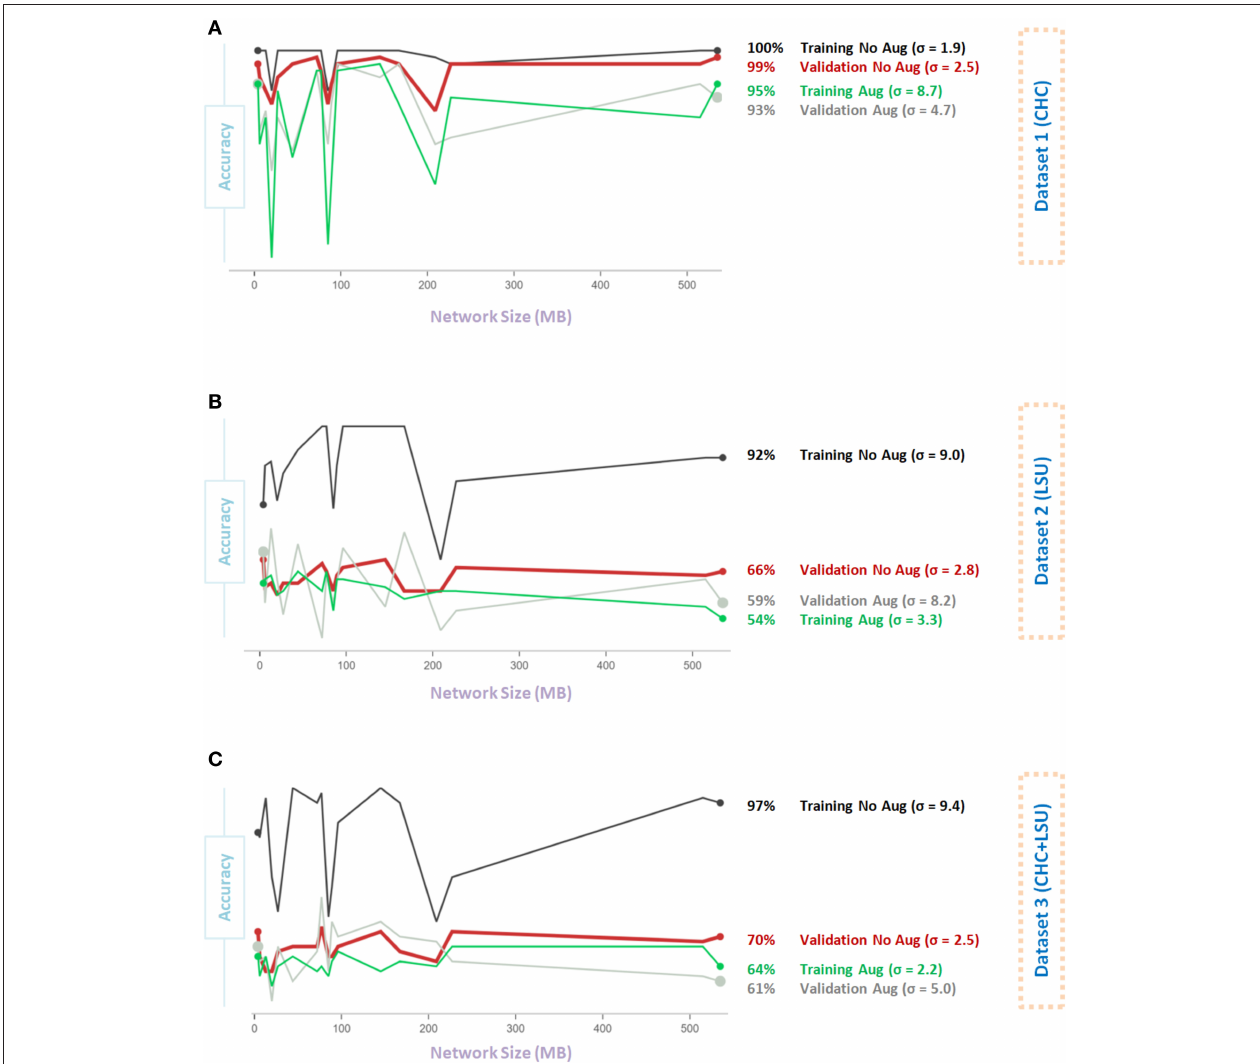
FIGURE 4 | Effect of network size on Data Augmentation 2 (22) for detecting X-ray images with and without COVID-19. (A) CHC Dataset. (B) LSU Dataset. (C) CHC+LSU Dataset. Here, σ refers to standard deviation of performance with respect to network size, which is calculated to measure stability over different network sizes, high value means less